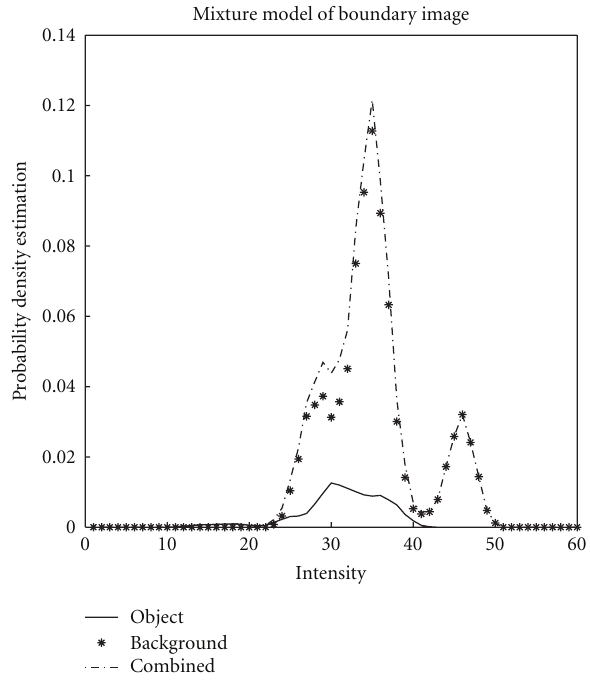
Figure 2: Estimated probability density functions of intensities of cell boundary pixels (solid line) and those that lie o ff the cell boundaries (background, asterisks), using manually labelled, intensity corrected data. The graph illustrates that the pixel inten- sity distributions of boundary and non-boundary pixels overlap strongly, even over small spatial scales. Adapted from [12].